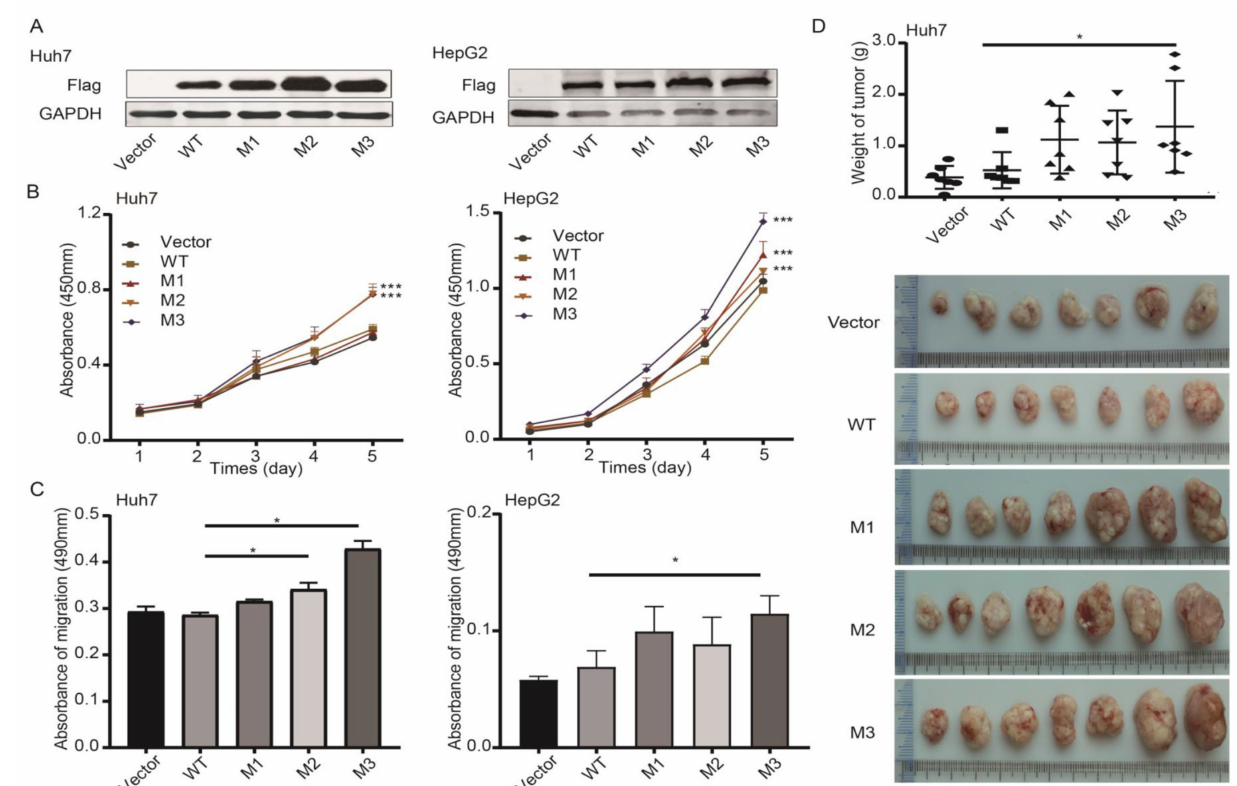
Figure 4. Effects of the preS1/preS2/S mutations on malignant phenotypes of cancer cells. ( A ) Ectopic overexpression of HBV preS1/preS2/S mutants and WT counterpart was confirmed by detecting Flag tag in Huh7 ( left ) and HepG2 cells ( right ). ( B ) Effects of preS mutations on the proliferation of Huh7 ( left ) and HepG2 cells ( right ). ( C ) Effects of preS mutations on the migration of Huh7 ( left ) and HepG2 cells ( right ). ( D ) The weight of xenograft tumors among different groups. * p < 0.05, *** p <